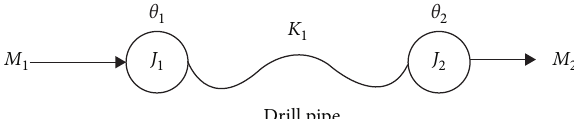
Figure 4: Dynamic model of elastic deformation of the drill pipe